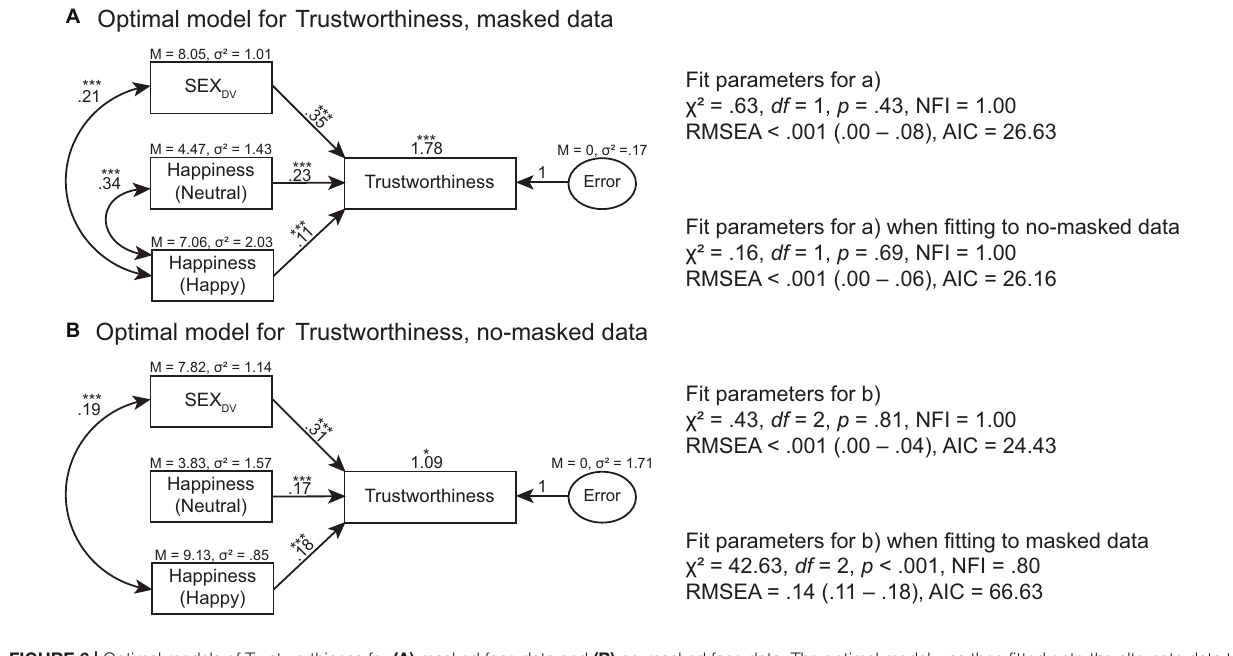
FIGURE 6 | Optimal models of Trustworthiness for (A) masked face data and (B) no-masked face data. The optimal model was then fitted onto the alternate data to evaluate the fit estimates. For example, the optimal model for masked face data was fitted onto no-masked face data to determine if the optimal model for masked face data could predict no-masked face data. *** p > 0.001, ** p > 0.01, * p > 0.05.